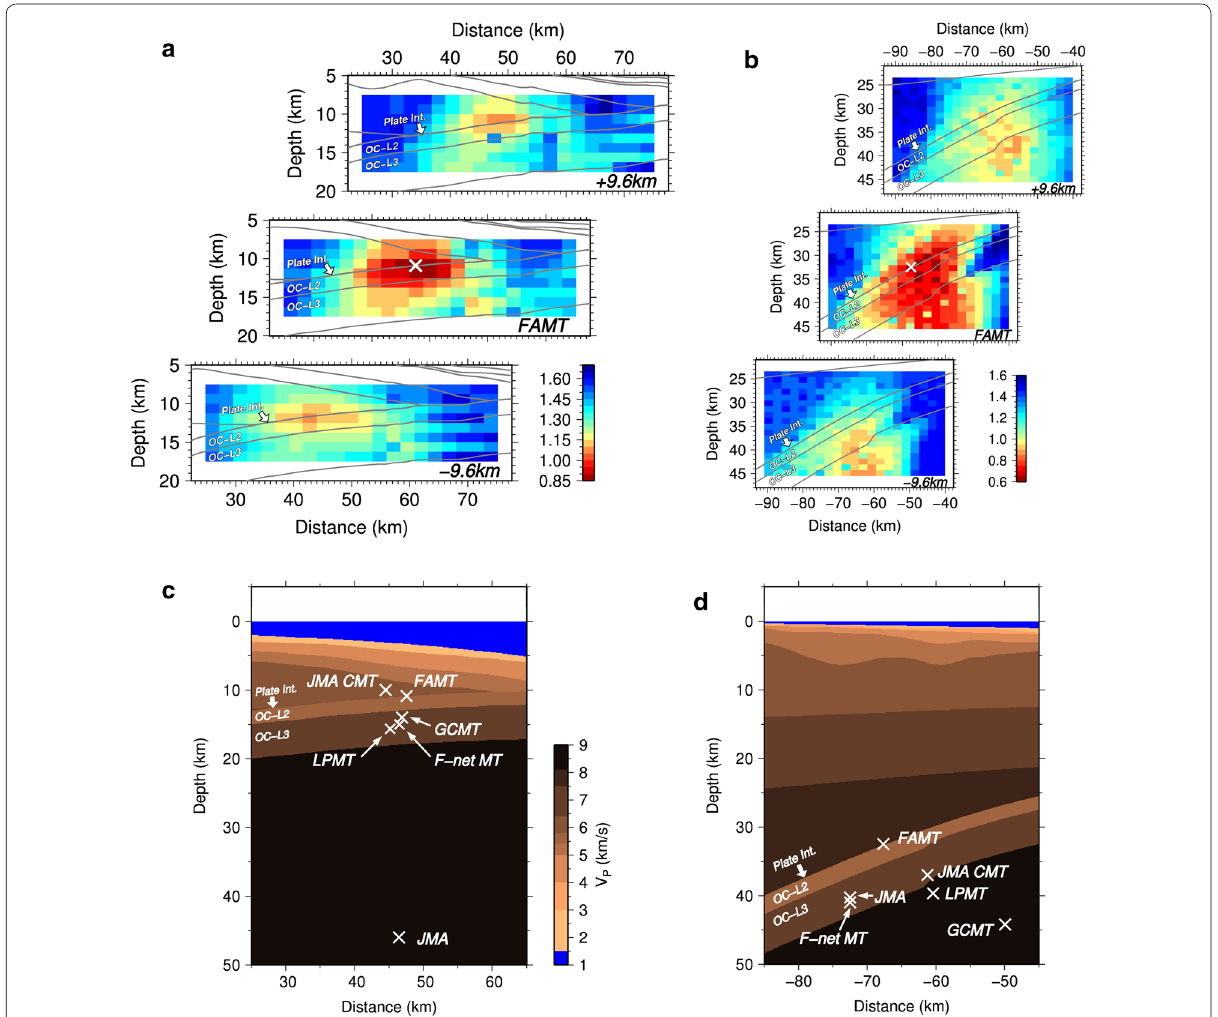
Fig. 2 a Vertical cross sections of the spatial distribution of the residual (Eq. 1) for EV2003 obtained by the spatial grid search performed with the best (0 s) origin time correction. The cross section through the best (FAMT) source position (middle), the cross section shifted from the middle one in the positive X direction by 9.6 km (top), and the cross section shifted from the middle one in the negative X direction by 9.6 km (bottom) are shown. Red corresponds to the small (good) residuals, and the best point is indicated by the white cross on the middle figure. Gray curves denote the interfaces of the 3D structure model. The plate interface (Plate Int.), layer 2 (OC-L2), and layer 3 (OC-L3) of the oceanic crust are indicated. b Same as a but for EV2007. c Various results of source position estimations for EV2003. The JMA hypocenter (JMA) and the positions of the F-net MT (best depth of a point moment tensor), the GCMT and the JMA-CMT (best locations of the centroids), and the FAMT (this study) are projected on the best cross section displayed in a . The “LPMT” (long-period MT) determined in this study is also projected (see text). d Same as c but for EV2007